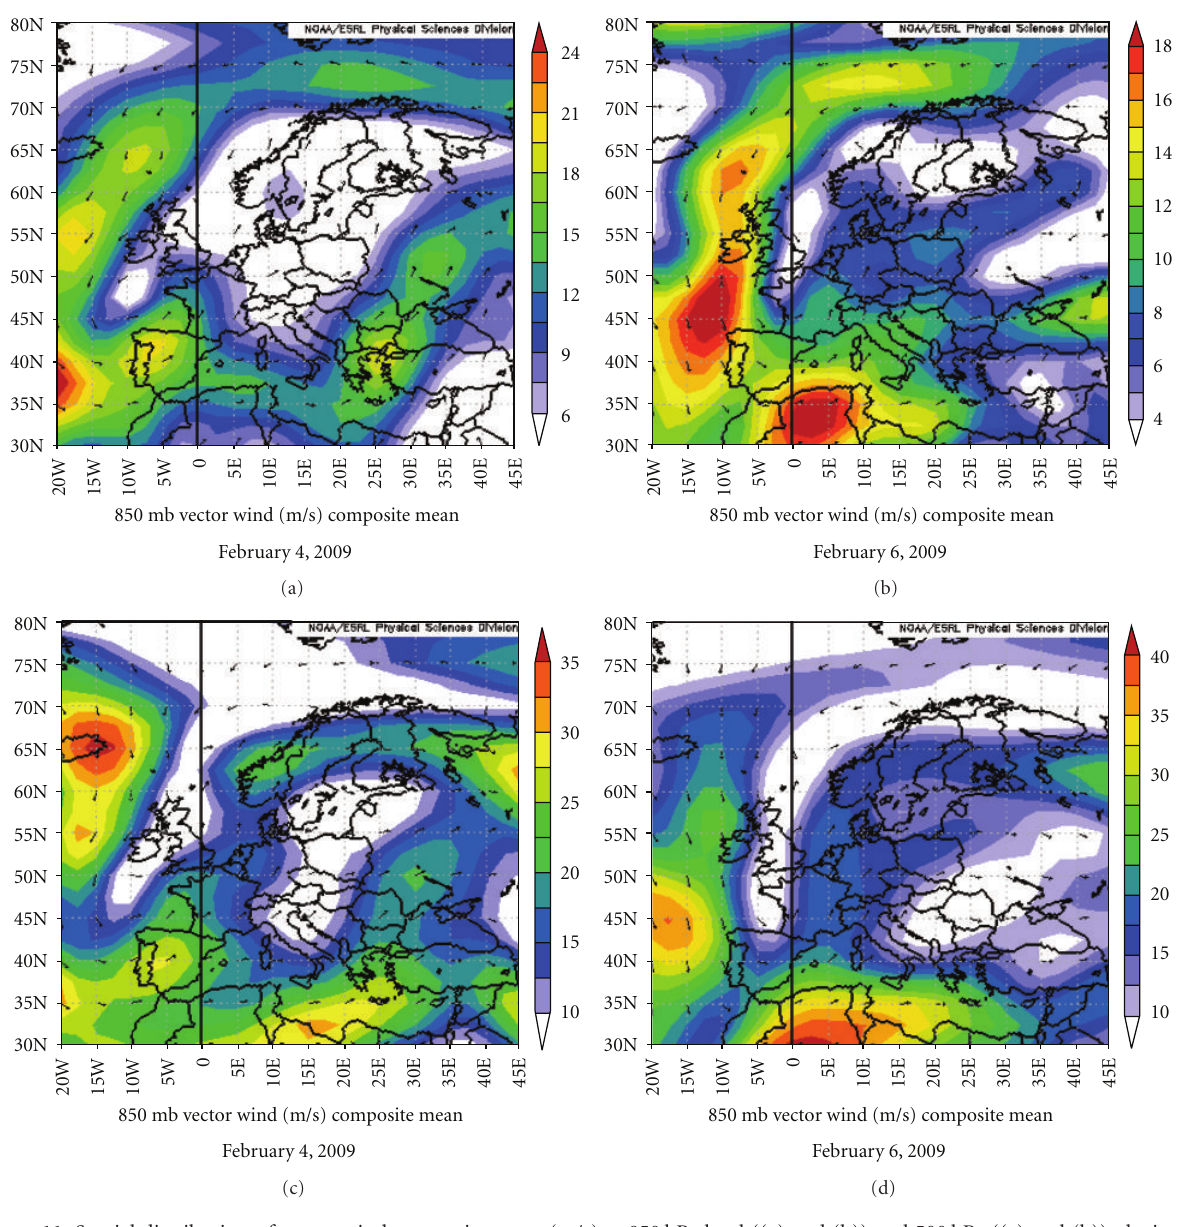
Figure 11: Spatial distribution of vector wind composite mean (m/s) at 850 hPa level ((a) and (b)) and 500 hPa ((c) and (b)), during the Saharan episodes on February 4, 2009 ((a) and (c)) and February 6, 2009 ((b) and (d)), using NCEP/NCAR reanalysis